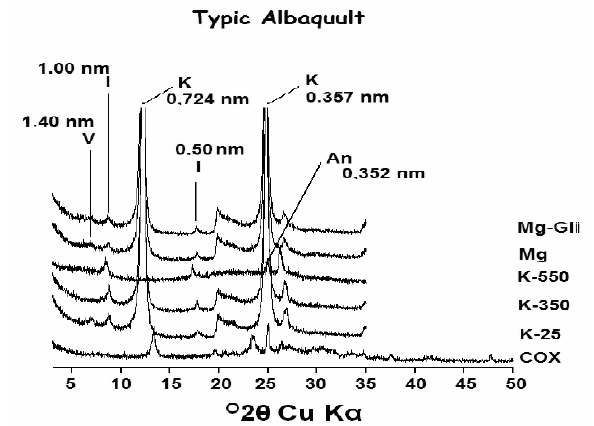
Figure 1. X ray diffractograms of the deferrified clay fraction and oxide concentrations in the Btg horizon of the typic Albaquult (GXbd). K: Kaolinite, I: Illite, An: Anatase, and V: Vermiculite